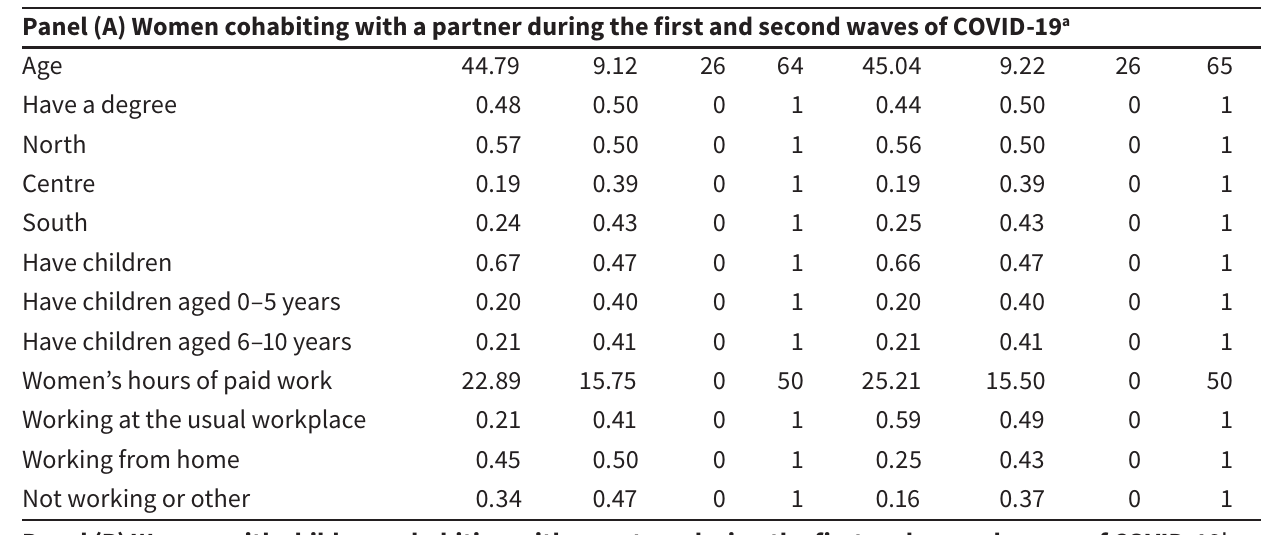
First wave of COVID-19 Second wave of COVID-19 Mean Std.